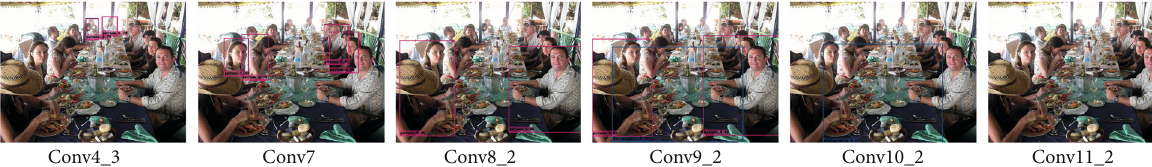
Figure 2: Detection results for each layer of SSD. In SSD, shallow layers are usually used to detect small objects and deep layers respond to objects in large scales.